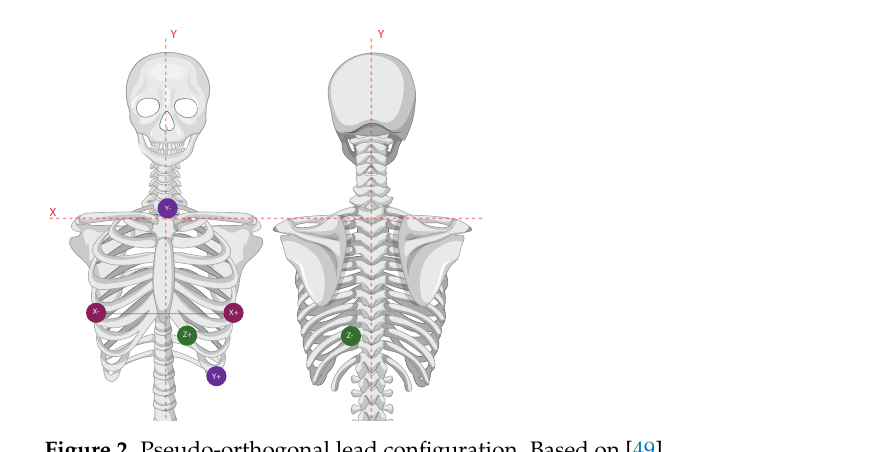
Figure 2. Pseudo-orthogonal lead configuration. Based on [49].